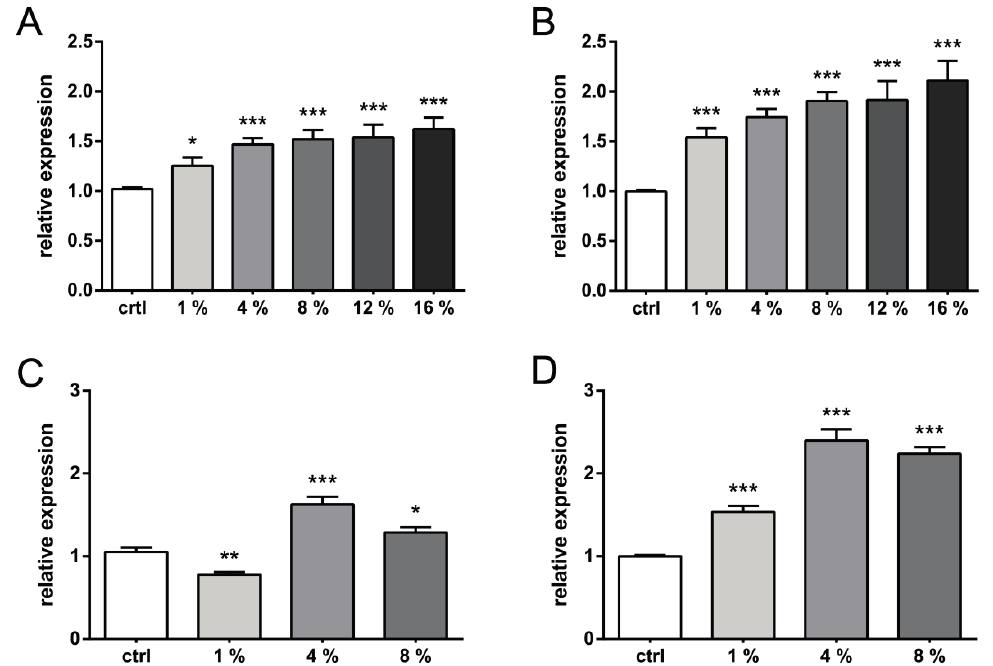
Figure 1. Strain-dependent vascular endothelial growth factor (VEGF) expression in C-28/I2 cells. Chondrocytes were strained in a FX-4000T system for 12 h. Using square waveforms and 0.5 Hz at 0%, 1%, 4%, 8%, 12% and 16% of strain ( A and B , respectively), VEGF expression was quantified immediately ( t ) ( A and C , respectively) or 24 h post 0 stretching ( B and D , respectively) using a VEGFA-specific enzyme-linked immunosorbent assay (ELISA). The experiment was repeated at 1 Hz using only 0%, 1%, 4%, and 8% of strain ( C and D , respectively). All values are normalized to the unstrained, parallel controls (set to 1). * , ** , and *** indicate significance levels of p ≤ 0.05, p ≤ 0.01, and p ≤ 0.001 respectively, n =